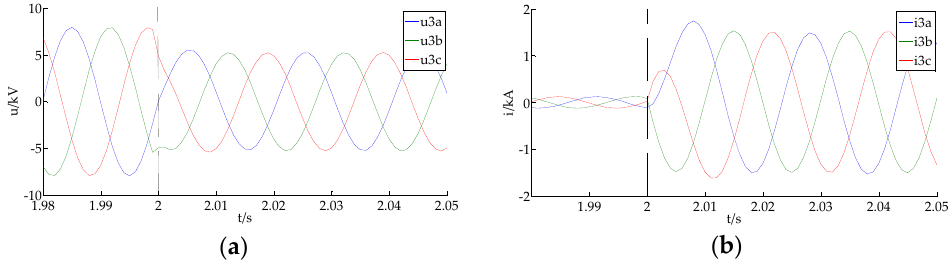
( b ) Figure 8. Voltage and current waveforms of Relay 4 during a three-phase fault at k1: ( a ) voltage; ( b ) current. Based on the symmetrical component method and using the Fourier algorithm, the PSFC’s voltage and current were extracted. The PSFC’s impedance angle at Relays 3 and 4 are − 115° (sensitive